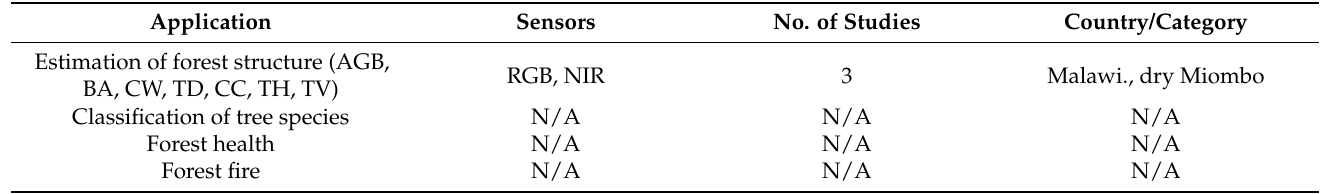
Table 5. Overview of UAS application status in the Miombo